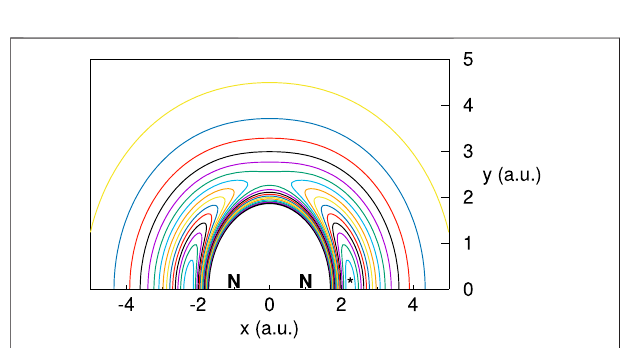
FIGURE 4 | (Color online) Isoenergy Contour plot for a positron around the nitrogen molecule fi xed at theequilibrium bonddistance.Contours startat − 4.5 eV ( + ) withalevel incrementalof0.3 eV.Theplot correspond to amodel potential with κ =0.5, ρ =2.05 and γ